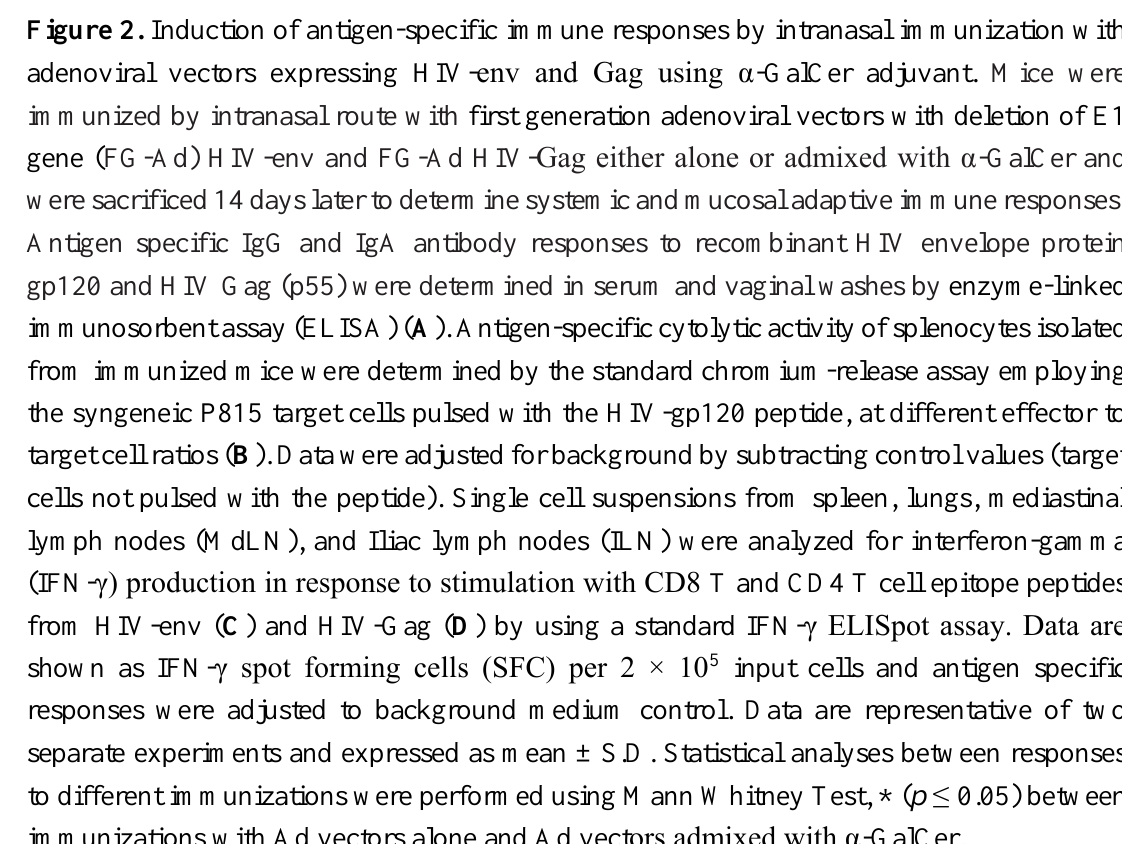
ResponseSpleen Lung M Envelope Specific CD4